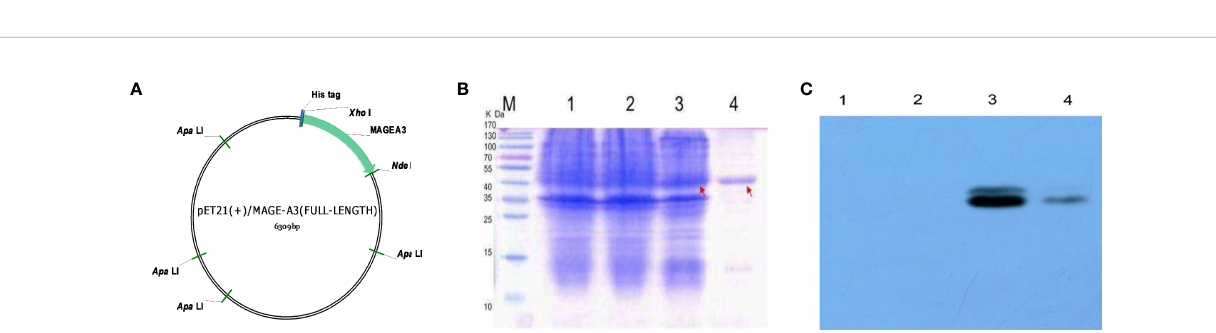
FIGURE 9 | Prediction potential miRNA of MAGEA3 in GC. (A) The predicted miRNAs targeting MAGEA3 in fi ve databases. (B) The expression correlation between predicted miRNAs and MAGEA3 in GC analyzed by starBase database. (C) The expression of hsa-miR-767-3p in GC and control normal samples determined by starBase database.